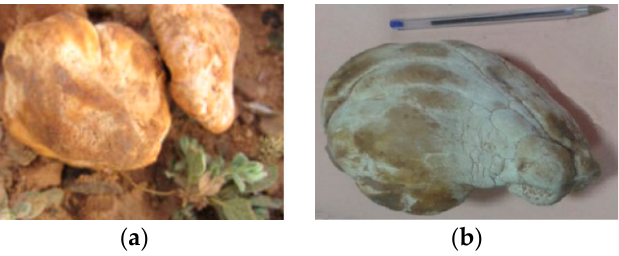
Figure 1. Desert truffles species: ( a ) Terfezia claveryi [5] and ( b ) Tirmania nivea [3].